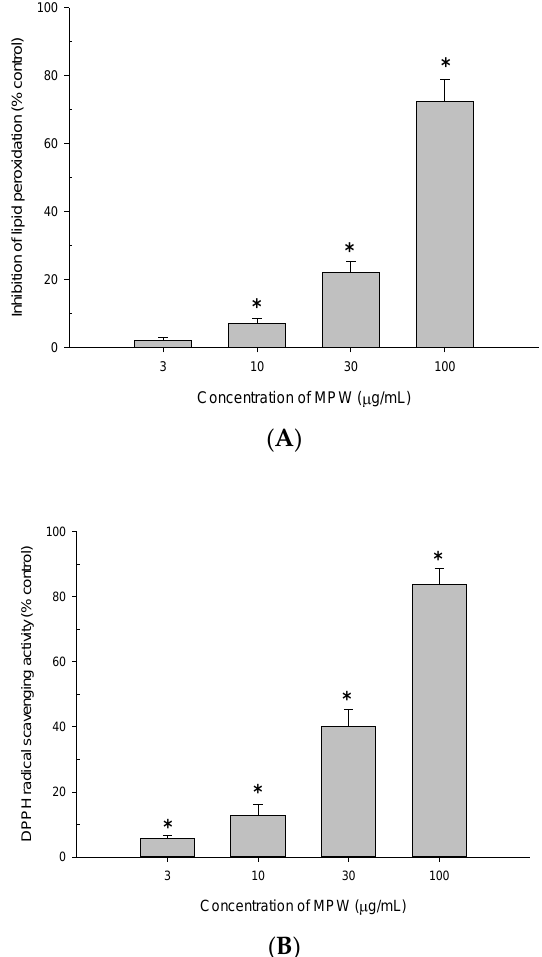
Figure 5. Effects of MPW on LPO and DPPH radical formation. Inhibition of LPO induced by Fe 2+ (10 µM) and L-ascorbic acid (100 µM) in rat forebrain homogenates ( A ) and DPPH radical formation ( B ) by MPW at the indicated concentrations were measured as described in the Materials and Methods. Each data point represents the mean ± S.E.M. from at least three independent experiments conducted in duplicate (*, p < 0.05 vs. LPO or DPPH radicals measured in the absence of MPW).